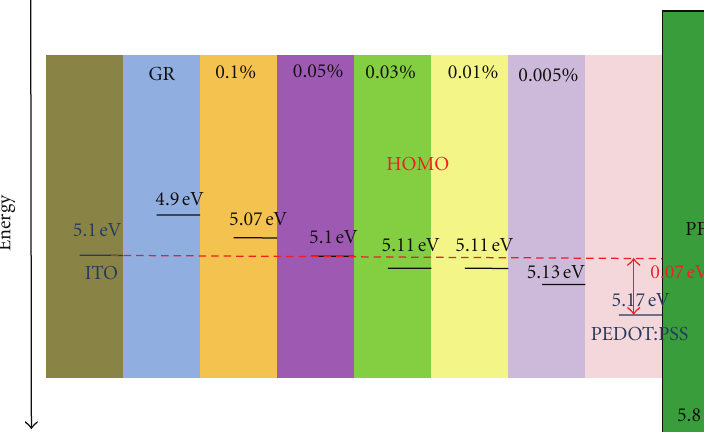
Figure 6: Schematic energy level diagram for the PEDOT:PSS/graphene nanocomposites with di ff erent graphene concentrations.